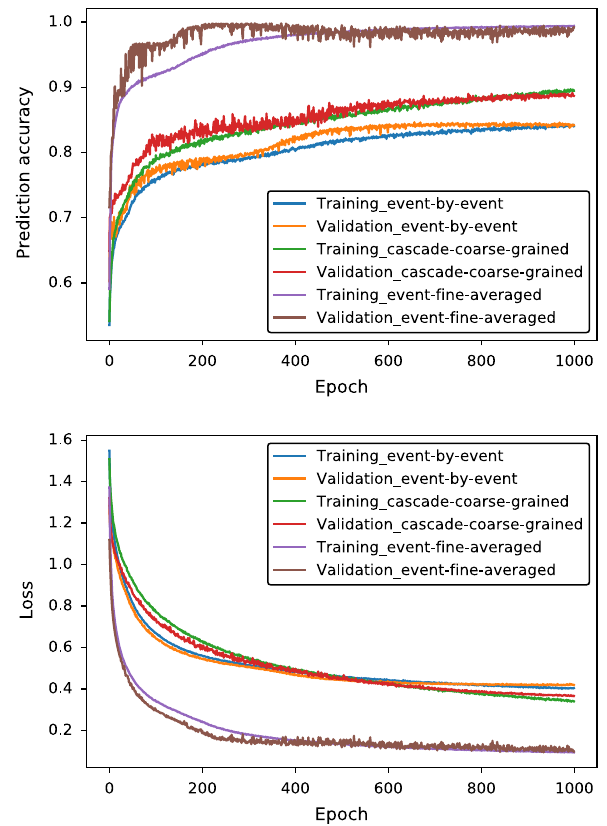
Fig. 2 Training and validation accuracy (upper panel) and loss (lower panel) in three different sub-scenarios with switching temperature T s w = 137 MeV. These three sub-scenarios refer to the 30-events- fine-averaged spectra (purple and brown), the cascade-coarse-grained spectra (red and green) as well as the event-by-event spectra (blue and